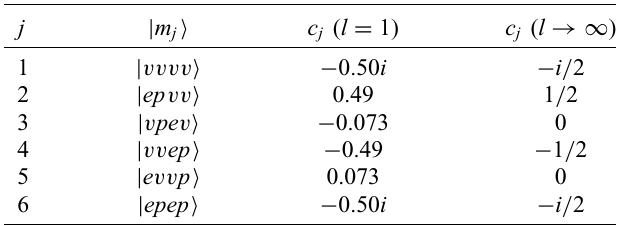
TABLE II. The c j for different truncations obtained from min- imizing Eq. (D1) that correspond to the matter subsystem of the ground-state of the Hamiltonian of the plaquette subject to OBCs for large g − 2